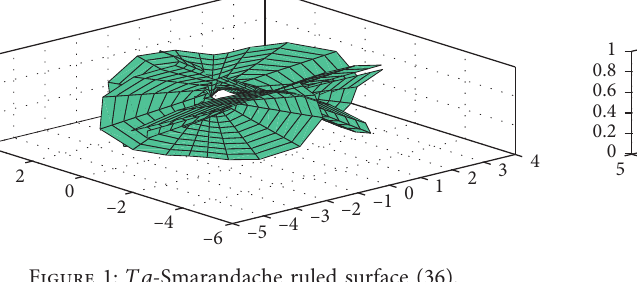
Figure 1: Tg -Smarandache ruled surface (36).